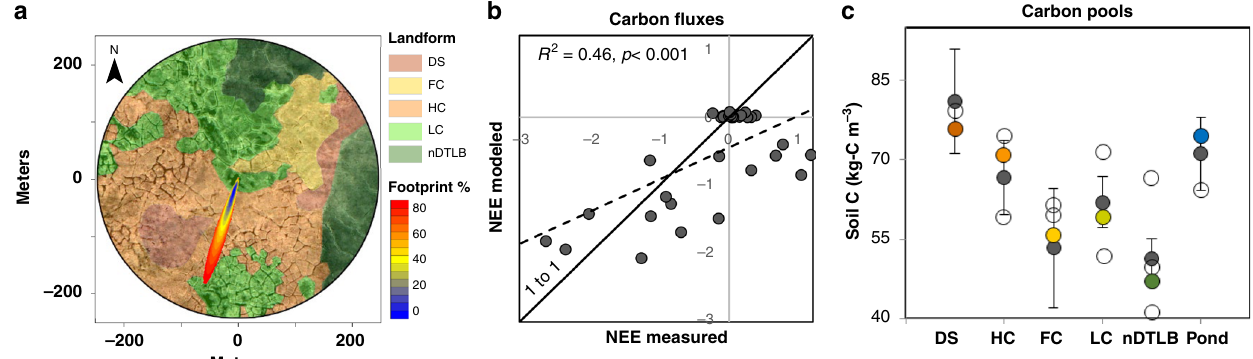
Fig. 3 Validation of modeled carbon fl uxes and carbon pools. Monthly net ecosystem exchange (NEE) fl uxes measured by the CARVE eddy covariance tower (71°19 ’ 22.72 ” N, 156°35 ’ 47.74 ” W, a ) during 2011 – 2015, were compared with NEE fl uxes simulated with DOS-TEM (dashed line in b ). Negative NEE indicates carbon uptake, while positive NEE indicates loss. Footprint % indicates the accumulated percentage of measured NEE used to compare with modeled NEE, weighted by polygonal landform (DS drained slope, HC high center, FC fl at center, LC low center, nDTLB nonpatterned drained thaw lake basins) using the Kormann and Meixner 93 fl ux footprint model (e.g., a ). Modeled carbon pools (colored circles; c ) were compared to 44 pedons collected (solid gray circles with standard error bars) and validated against 11 independent random subset of soil carbon pedons (open circles) measured on each respective landform across the Barrow